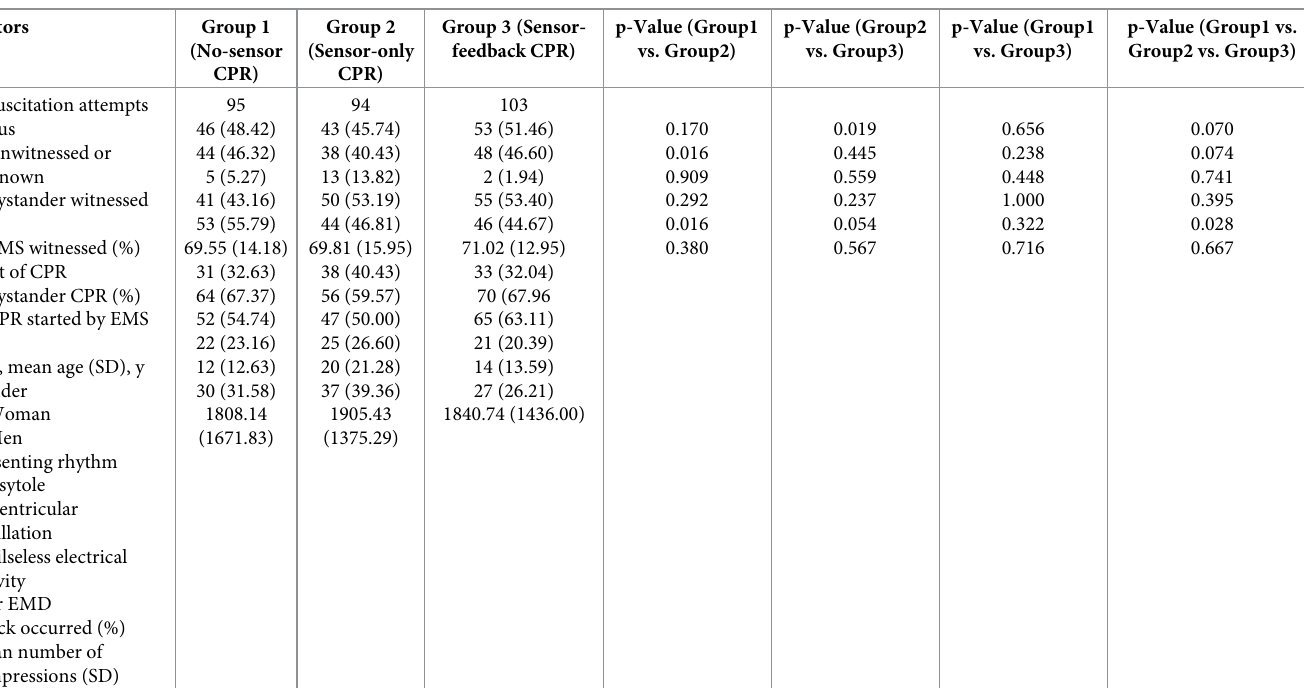
Table 2. Utstein characteristics.